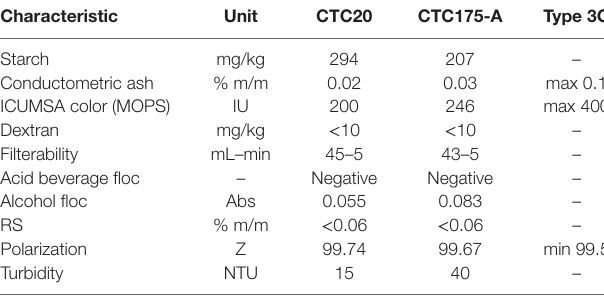
TaBle 7 | Physicochemical parameters of example raw sugar lots produced from control cultivar CTC20 and CTC175-A including relevant copersucar raw